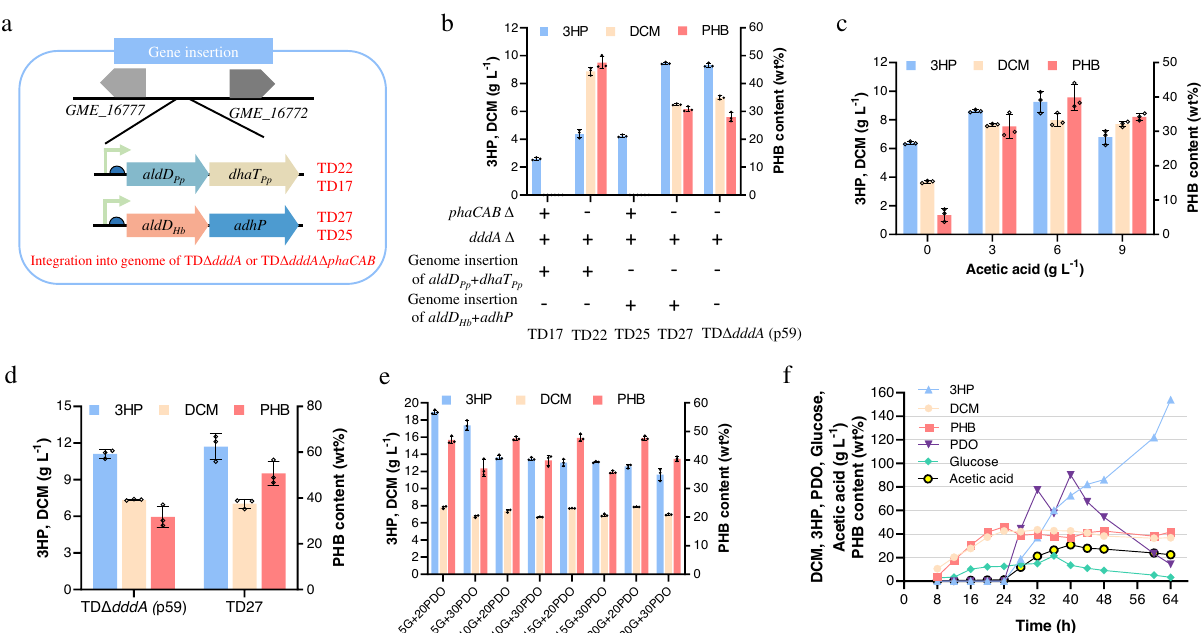
Fig. 4 Combinatorial optimization to increase 3HP production. a Genome engineering strategy and genetic constructs used for genomic integration. b Genome-overexpression and deletion of enzymes in the 1,3-propanediol to 3HP biosynthetic pathway enhanced 3HP production. Gene dddA and PHB synthesis operon phaCAB encoding 3HP degradation enzyme and PHB synthesis enzymes were deleted, respectively. 1,3-propanediol to 3HP biosynthetic pathway of P. putida KT2440 and H. bluephagenesis were inserted into H. bluephagenesis TD Δ dddA and H. bluephagenesis Δ dddA Δ phaCAB , respectively.